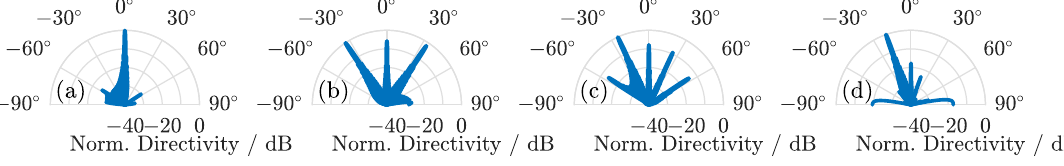
Figure 6. Calculated radiation pattern of a terahertz wave at 0.6THz reflected by the grating ( a ) with two reflectors per grating period, ( b ) with three reflectors per grating period, ( c ) with four reflectors per grating period, and ( d ) with five reflectors per grating period.